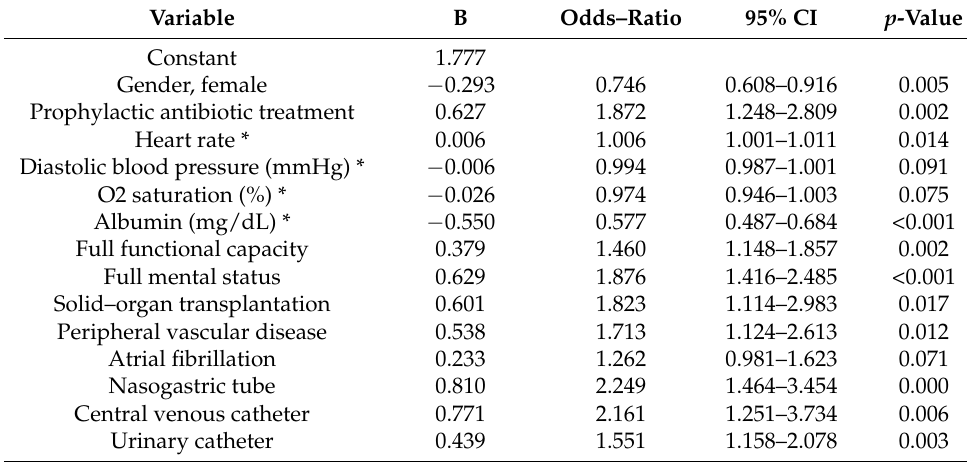
Table 2. Logistic model coefficients for calculating the probability of antibiotic treatment during